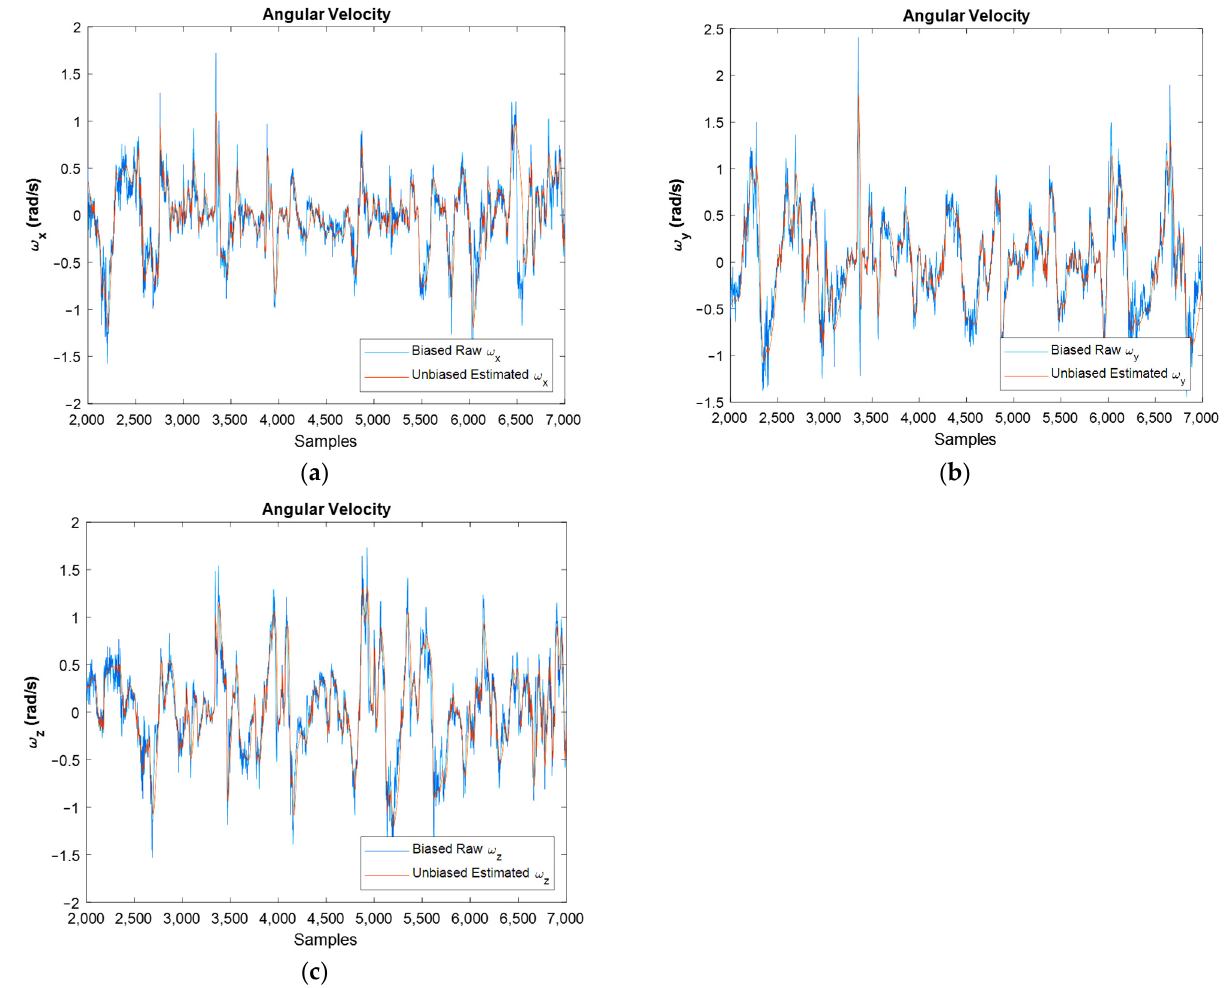
Figure 13. Estimated unbiased angular velocity for x , y , and z direction against raw ones: ( a – c ), respectively.